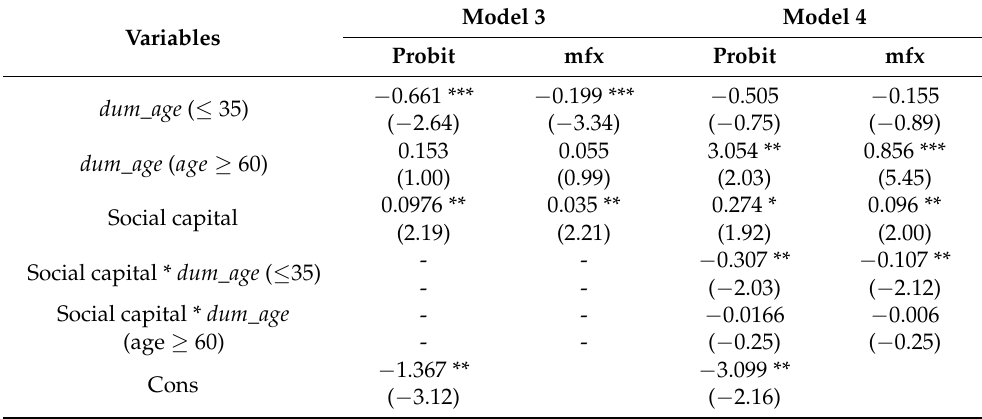
Table A1. Results of the Probit model evaluation and marginal effects without control variables.